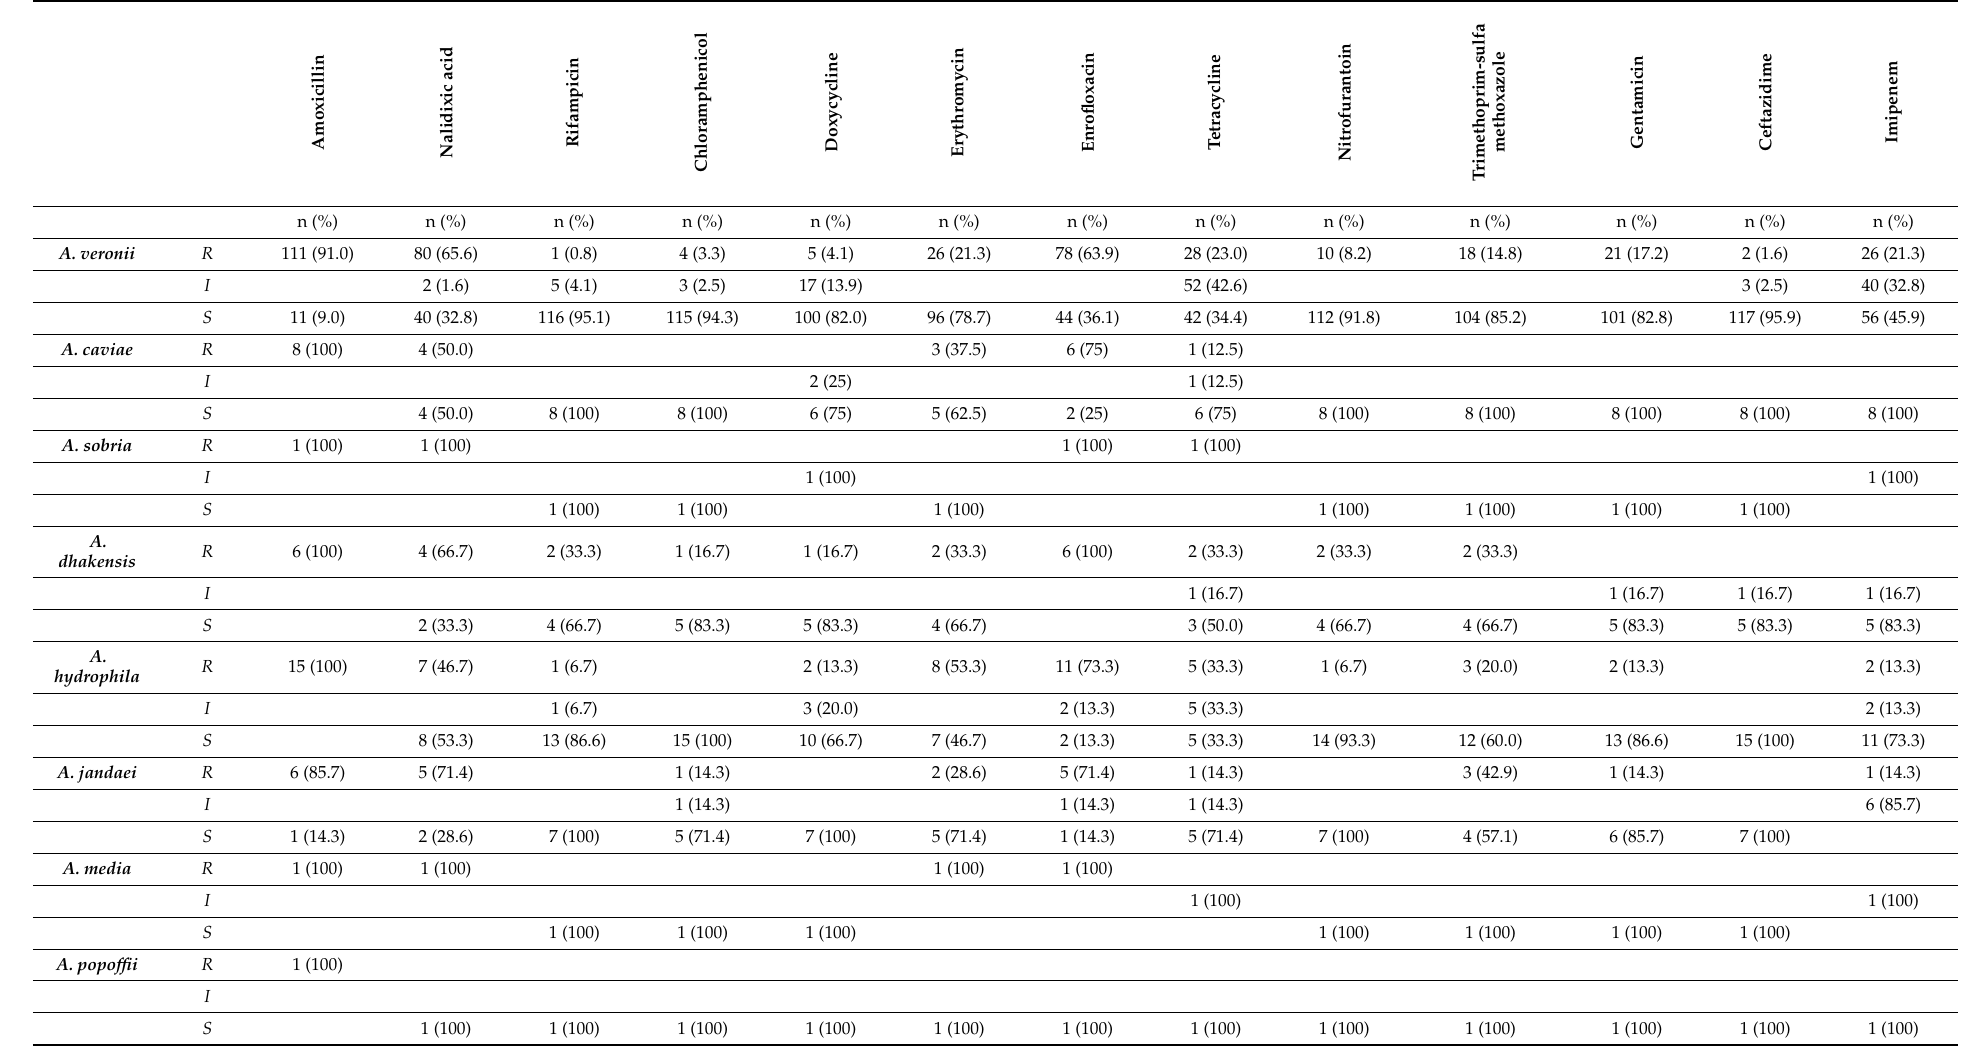
Table 3. Distribution of antimicrobial susceptibility among Aeromonas spp. to thirteen